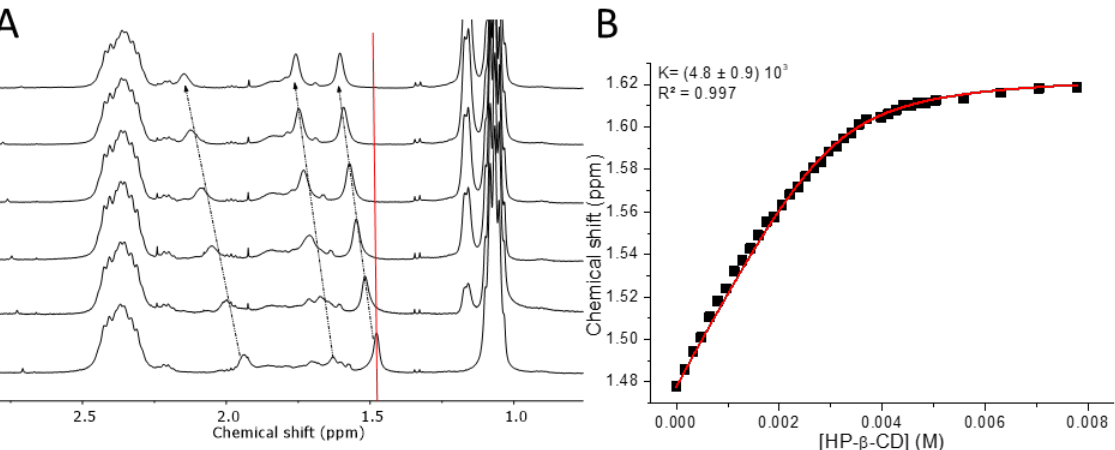
Figure 5. ( A ) Stacked 1 HNMR spectra of the titration of P(EtOx- stat -AdamantanOx) (5 mg/mL in D 2 O with an increasing HP- β -CD concentration in increments of 0.2 equivalents, relative to the adamantane groups from bottom to top). The arrows and red line indicate the peaks of interest and guide the eye. ( B ) Binding isotherm obtained from the titration experiment, whereby the chemical shift is plotted as a function of the HP- β -CD concentration. The applied fitting is displayed in red. Subsequent plotting of the chemical shift ( δ obsd ) of the adamantane signal around 1.48 ppm as a function of the HP- β -CD concentration ([CD] 0 ) enabled the determination